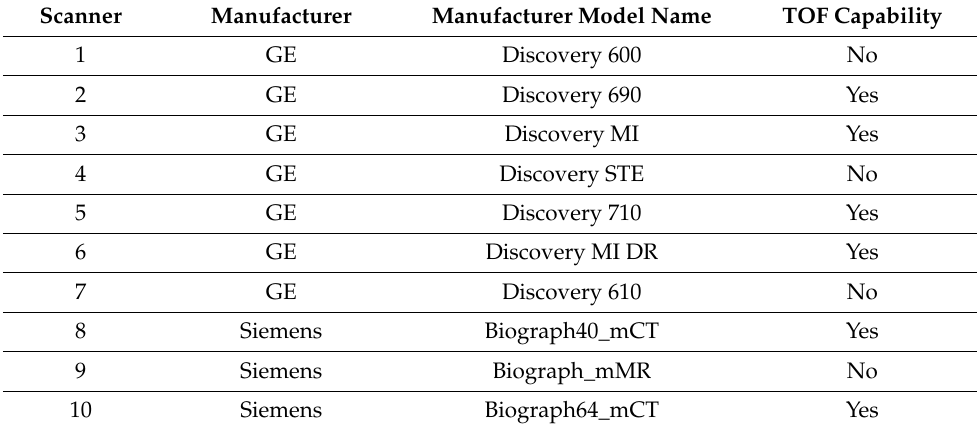
Table 1. GE = GE Medical Systems (Waukesha, WI, USA). Siemens = Siemens Medical Solutions USA, Inc. Malvern, PA,